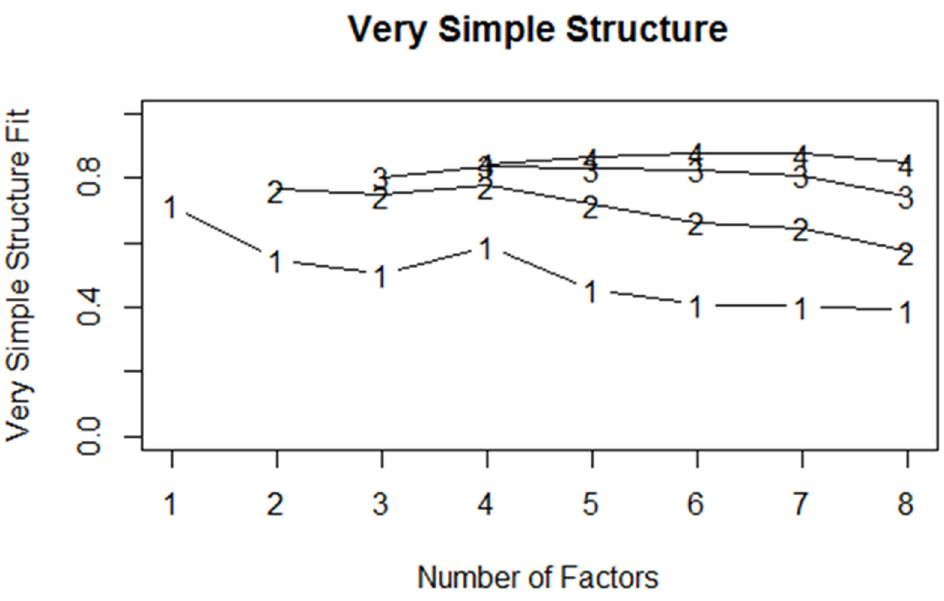
Figure 2. VSS plot of the CBS-M model.